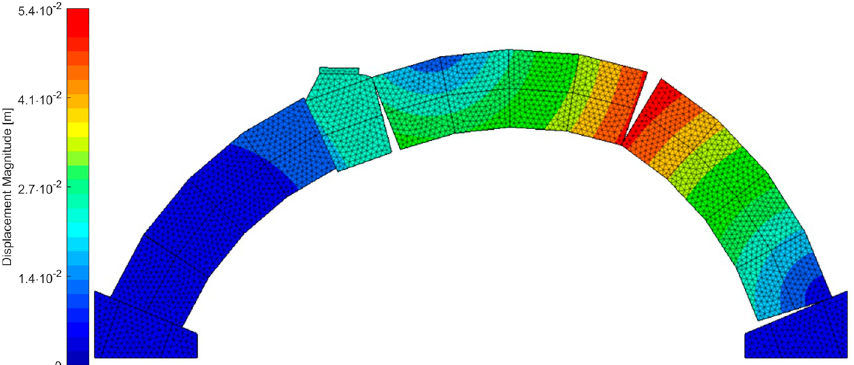
Figure 22. Failure mode of densely meshed geometry for best set of material parameters using objective function 1; the colour legend represents the displacements in metres.